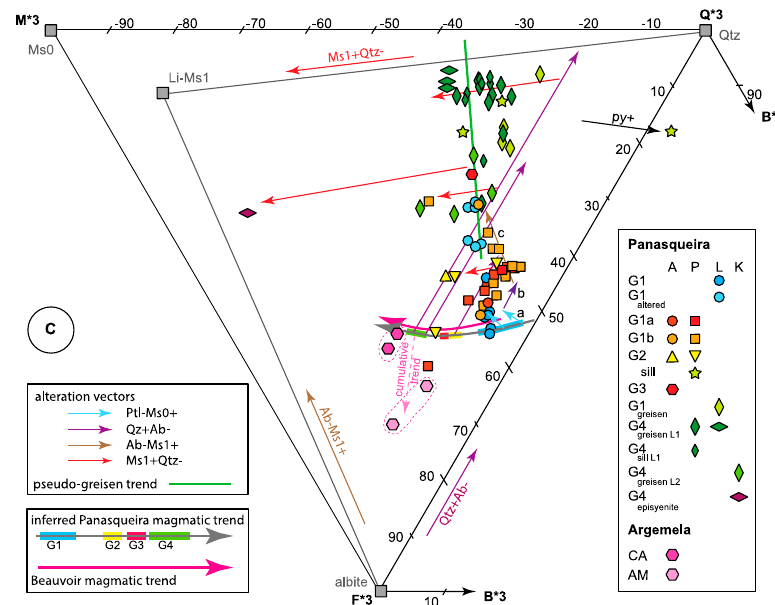
Figure 25. Disentangling magmatic and alteration trends of the Panasqueira granites and greisens in the appropriate chemical-mineralogical diagrams. The nearby Argemela RMG and the Beauvoir RMG trend are plotted in the same diagrams as a reference. Data from [15–18,57,58]. Inserts: definition of alteration vectors. Ms0: early muscovite; Li-Ms1: main muscovite; Ms0+ vector: alteration vector corresponding to the early muscovitisation (Ms0 growth); Ms1+ vector: alteration vector corresponding to main muscovitisation (Ms1 growth); Qtz+: alteration vector corresponding to quartzification; Qtz-: alteration vector corresponding to quartz dissolution: Ab-: alteration vector corresponding to albite dissolution. For the construction of all diagrams, the parameters are corrected to take into account both the calcium excess in apatite (for AB and QP diagrams) and the iron excess due to the presence of sulfur (for all diagrams), at least when sulfur analyses are at hand (see Table S2). Such iron excess is still visible for some analyses plotted in the different diagrams, where it is signaled by a “pyrite +” vector. ( A ) Interpretation of the Panasqueira granites and greisens compositions in the A-B diagram (see File S1 for explanations). In this diagram, where quartz and the feldspars project at the origin, the A parameter is set to represent peraluminosity, whereas the B parameter corresponds to the mafic components. In this diagram, it is much easier to check the effects of muscovite on the alteration trends. It appears that the succession of quartzification and muscovitisation in the G2-G4 suite conducts to a bulk alteration trend, nearly orthogonal to the real greizenisation trends (pseudo-greisen trend), whereas in the G1 suite, the effects of the early muscovitisation (Ms0) are predominant. Inversing the alteration trends allows us to reconstruct a pristine Panasqueira magmatic trend, which appears to be very similar to those of typical RMG of the Beauvoir type. ( B ) Interpretation of the Panasqueira granites and greisens compositions in a QP diagram (see File S1 for explanations). In this diagram, it is particularly evident that the G1 suite is poorly affected by the alterations affecting the G2-G4 suite. Owing to the limited effects of early muscovitisation, the G1 suite still displays a magmatic evolution trend very similar to the less evolved part of the Beauvoir RMG trend. Inversing the process in the greisens allows a prolongation of the trend towards the G2-G4 sequence. ( suite ) ( C ) Interpretation of the Panasqueira granites and greisens compositions in the Q*3B*3F*3 diagram. In this double triangular diagram, with parameters Q*3 expressing quartz, and F*3, the feldspars, B*3 opposes mafic minerals (the positive values), and peraluminous components (the negative values, expressed as M*3) (see File S1 for explanations). In this diagram, in the G1 suite, the albite transformation into Li-Ms1 and a limited quartzification become sensitive, both alterations having succeeded in the early muscovitisation (Ms0) (the a-b-c sequence in the diagram). As a consequence, the corresponding alteration trends are aggregated, with the pseudo-greisen trend still prevailing in the G2-G4 suite. Inversing the process allows us to reconstruct the Panasqueira magmatic trend, which, here as in A and B, appears similar to the classical Beauvoir trend.